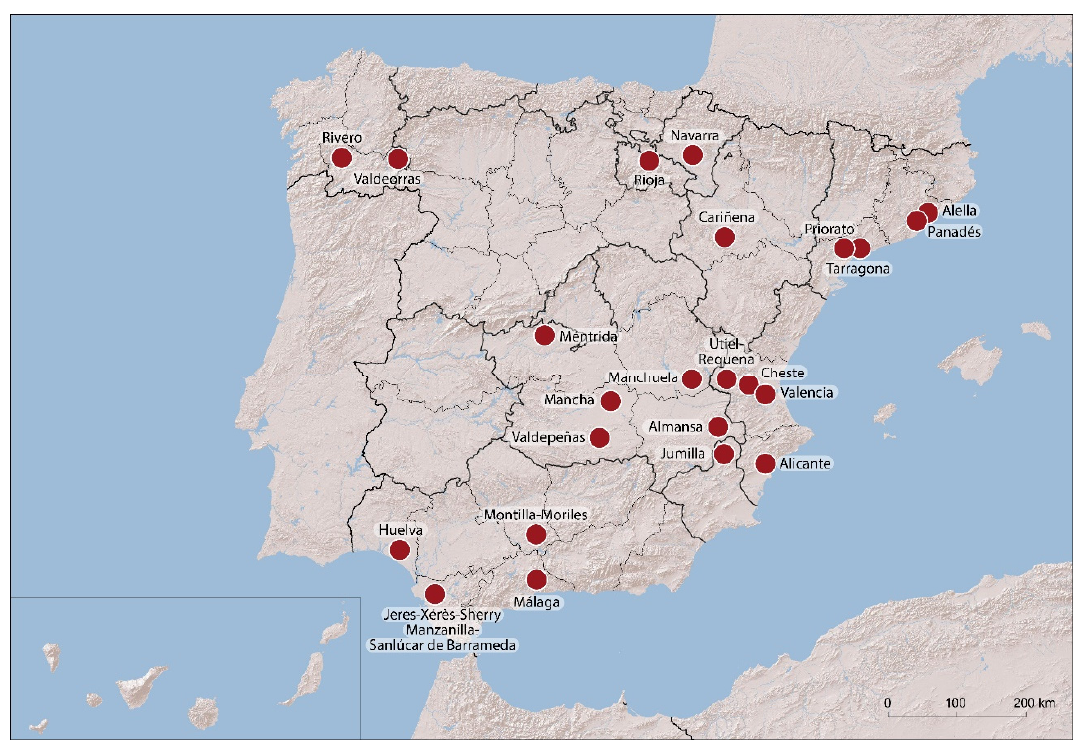
Figure 8. DO operating in Spain in 1970. Source: Law 25/1970 of Statute of the vineyard, wine and alcohols. Own elaboration.